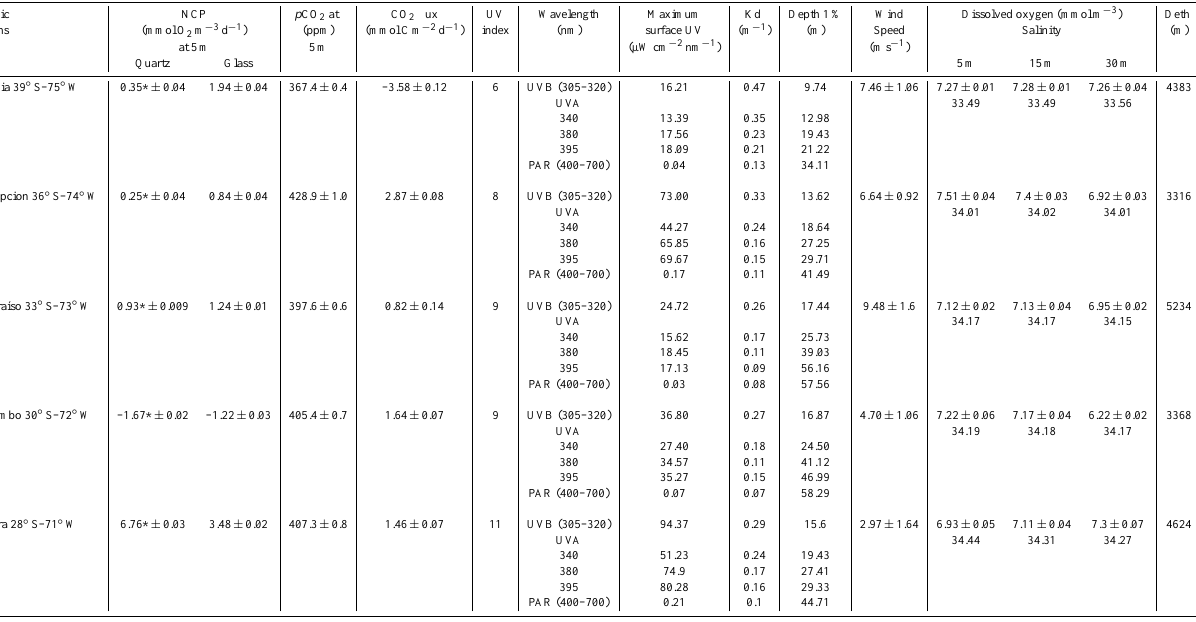
Table 2. Location of the open ocean sampling stations, and net community metabolism ( ± SE) in surface waters under the full irradiance (quartz incubations) and after excluding UVB radiation (glass incubations), the mean p CO 2 ( ± SE) and air sea CO 2 flux ( ± SE), UV index and maximum incident surface UV during the metabolism experiments, the extinction coefficients ( K d ) and the depth of 1% of surface irradiance for UVB, UVA and PAR; average wind speed, dissolved oxygen concentration and salinity at the surface, and the depth of the